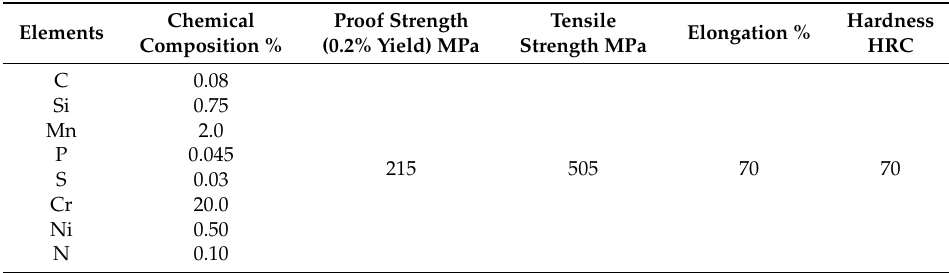
Table 1. Chemical composition and mechanical properties of AISI 304 [24].